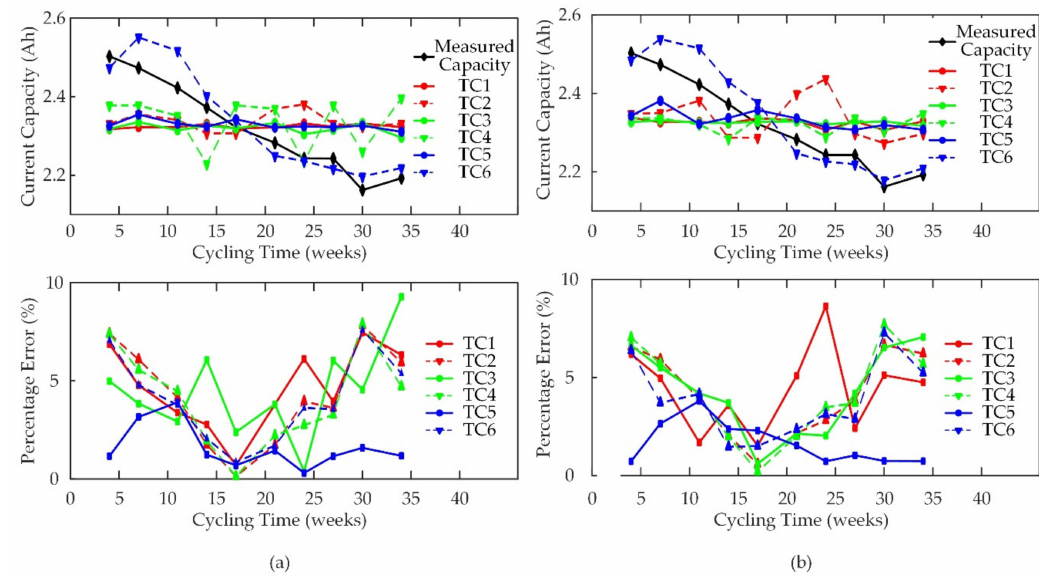
Figure 13. Estimation results under six test conditions. ( a ) Approximate entropy-based method; ( b ) Sample entropy-based method.